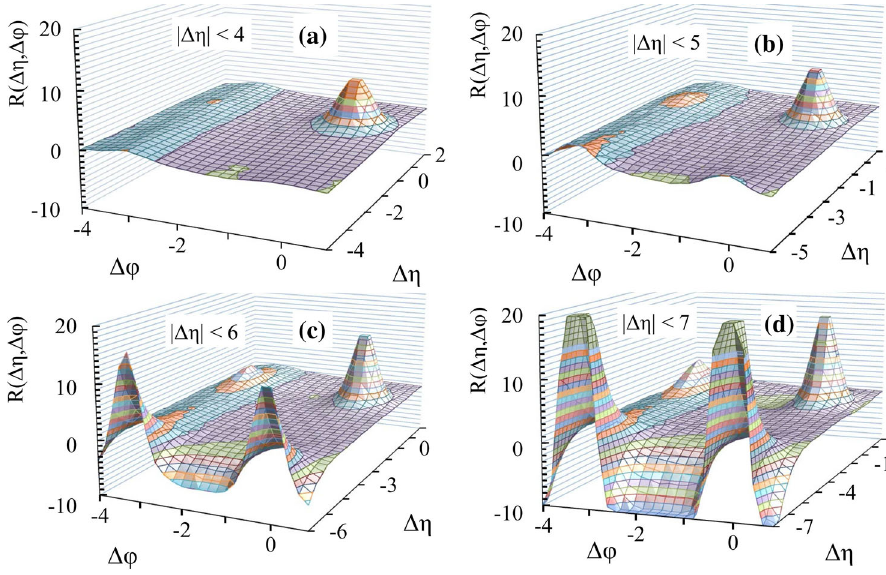
Fig. 8 R (Δη,Δϕ) distributions simulated by FANSY 2.0 CPG (“moderate”) for high-multiplicity events at | Δη | ≤ 4 ( a ), | Δη | ≤ 5 ( b